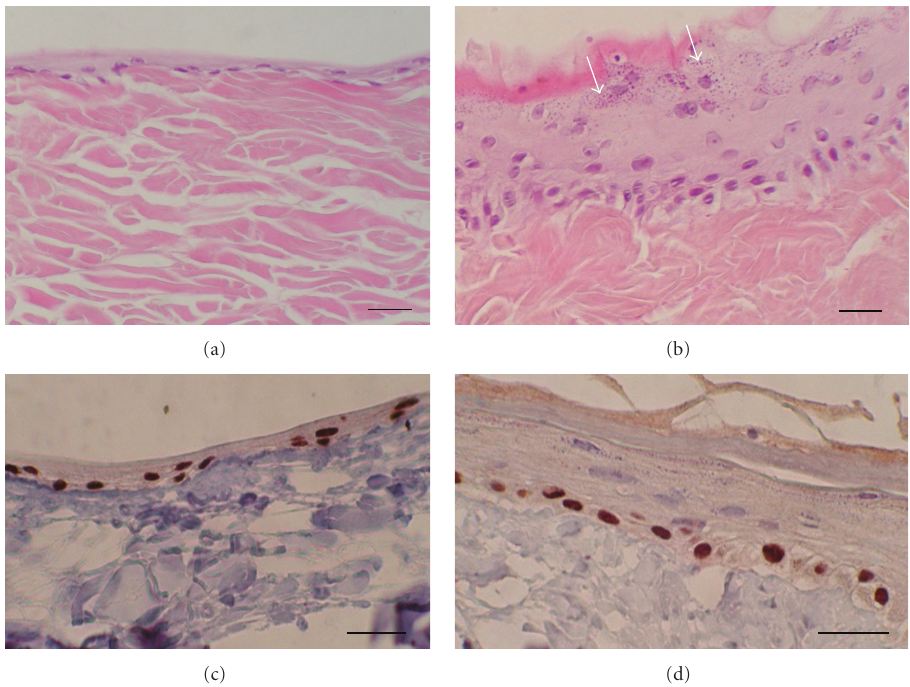
Figure 5: Keratinocytes cultured and di ff erentiated on XD . (a) Keratinocytes grown submerged formed 1-2 layers on XD. (b) Keratinocytes grown at the air-liquid interface formed the basal, spinous, and granular layers. Keratohyalin granules (arrows) in the granular layer are notable. (c) Keratinocytes grown submerged stained immunocytochemically for p63 (nuclear protein p63 is expressed in basal cells). (d)